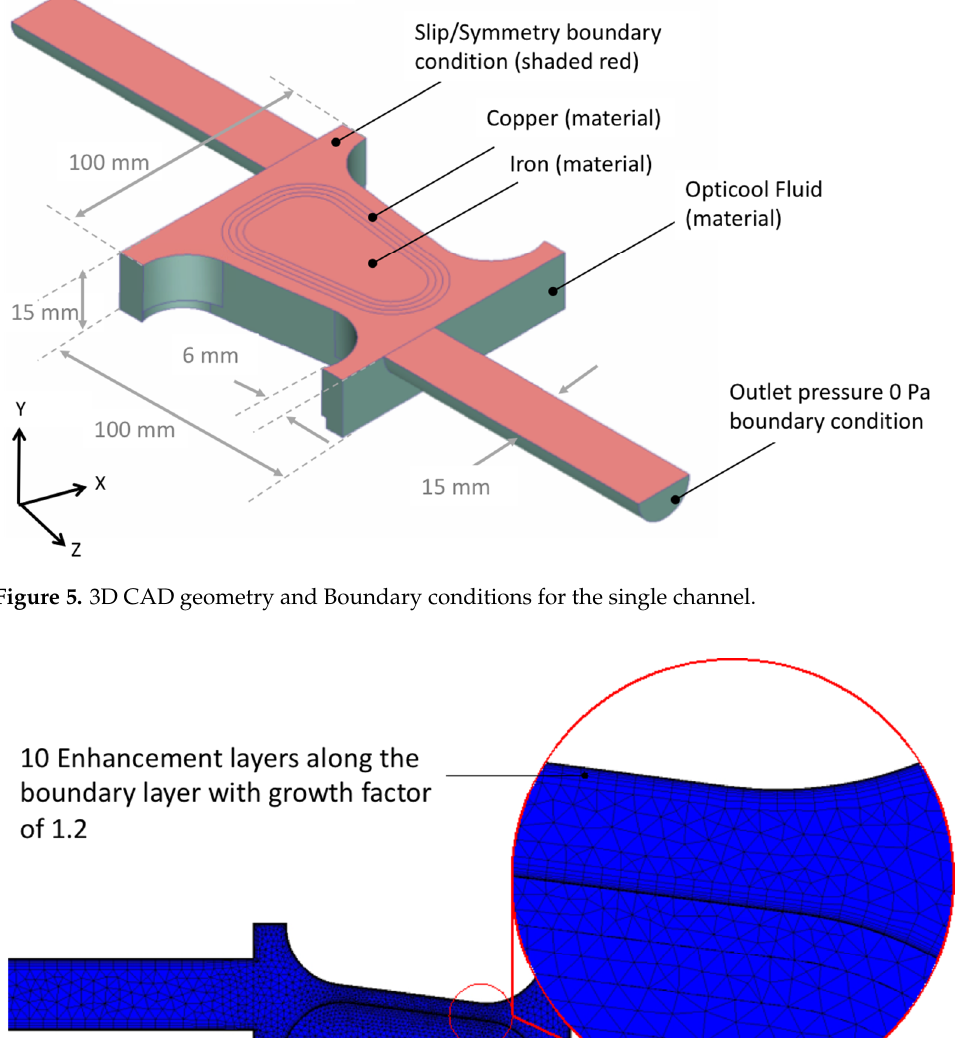
Figure 4. Example of the comparison between ( a ) the traditional pole piece and ( b ) the new con- struction with heat sink integrated within the windings. Table 2. List of properties for SMC and copper windings.